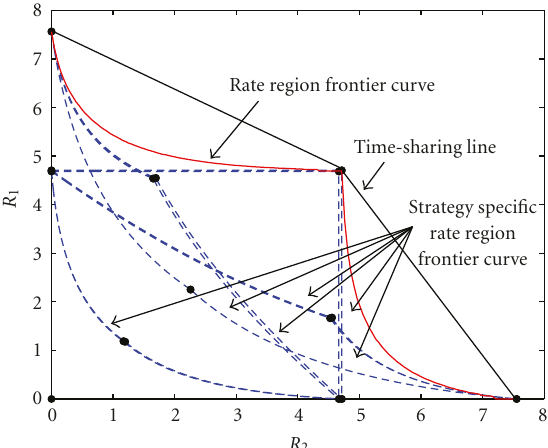
Figure 6: Achievable rate region for the OFDM interference channel—results averaged over 2000 channel realizations.